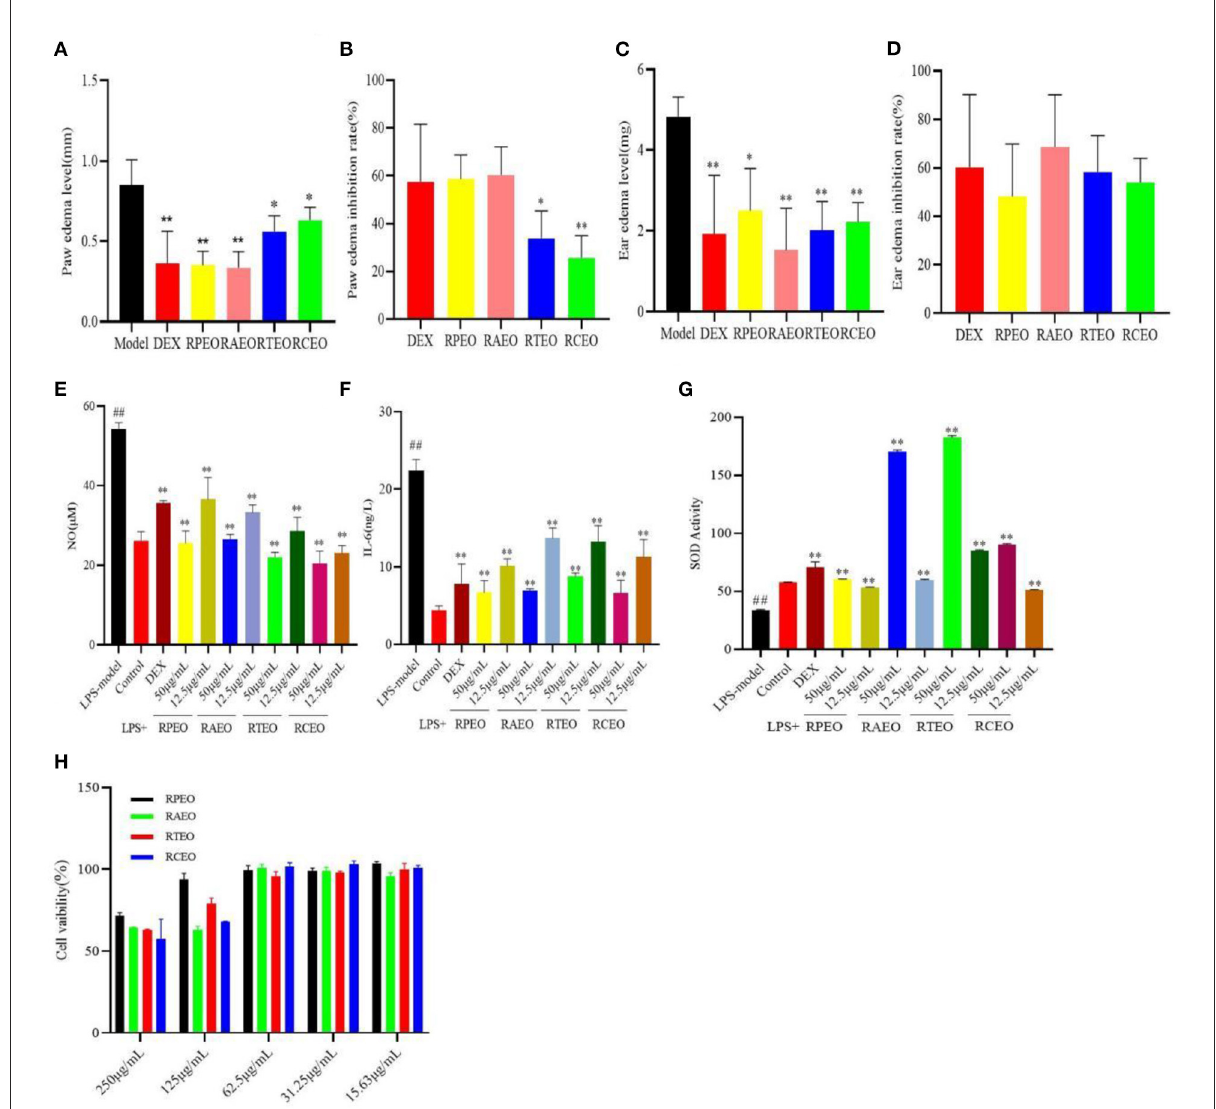
FIGURE2 The paw edema level (A) and its inhibition level (B) of carrageenan-induced paw edema in mice test, and the ear edema level (C) and its inhibition level (D) of xylene induced ear edema test, the inhibitory effect of these compounds on NO production (E) , IL-6 production (F) and SOD activity (G) in RAW264.7 cells induced by LPS, (H) the cell viability of four Rhododendrons species essential oils against RAW264.7 cells. ( ## represent the significant difference between control group and model group, p < 0.01; * p < 0.05 represent the significant difference between model group and drug-treated group; ** for p < 0.01